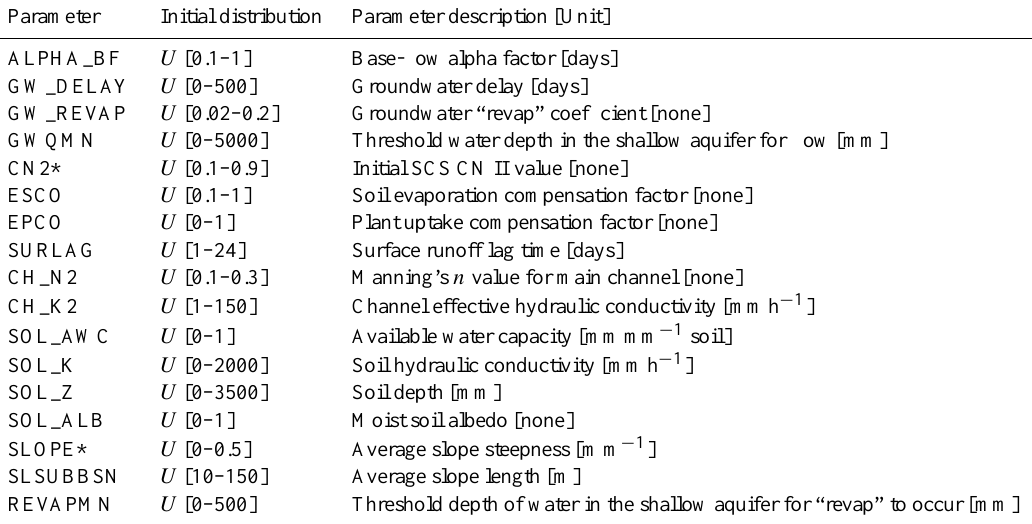
Table 3. Initial range, sensitivity analysis results and description of the selected SWAT model